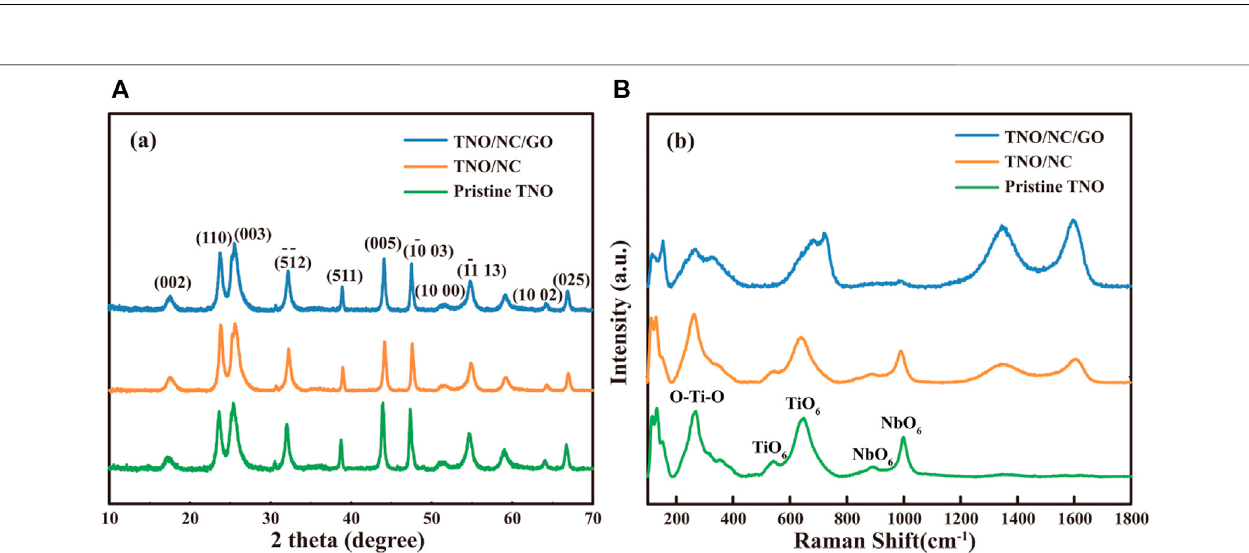
FIGURE 2 | (A) XRD patterns of pristine TNO, TNO/NC, and TNO/NC/GO nanocomposites; (B) Raman spectra of pristine TNO, TNO/NC, and TNO/NC/rGO nanostructures.